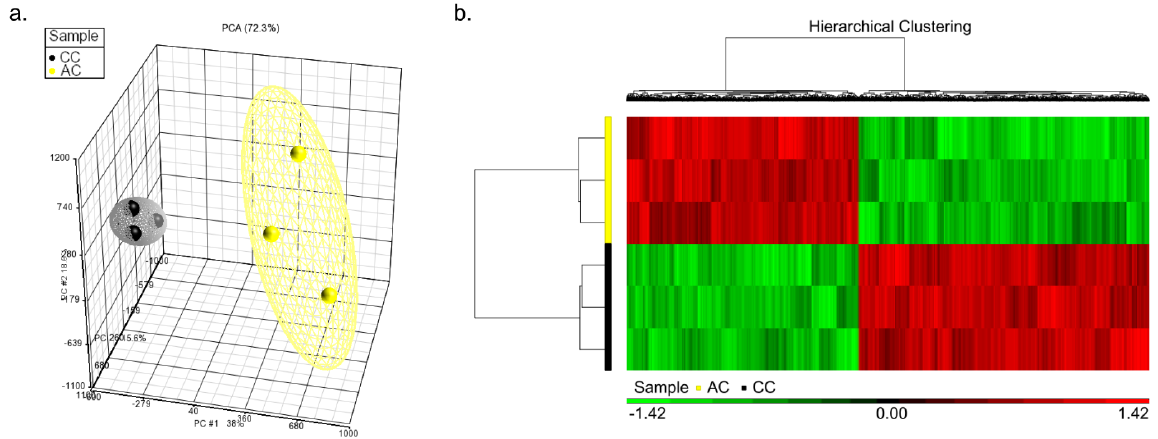
Figure 3. ANOVA of neonatal and adult CpG methylation. We compared the three CC and three AC M850K microarray data using Partek. ( a ) The PCA plot demonstrated substantial discrimination between CC and AC samples. ( b ) At FDR < 0.05 and β variation > 0.1, 33,150 CpG dinucleotides differed significantly, 44.34% of which were hypermethylated in treatment AC.